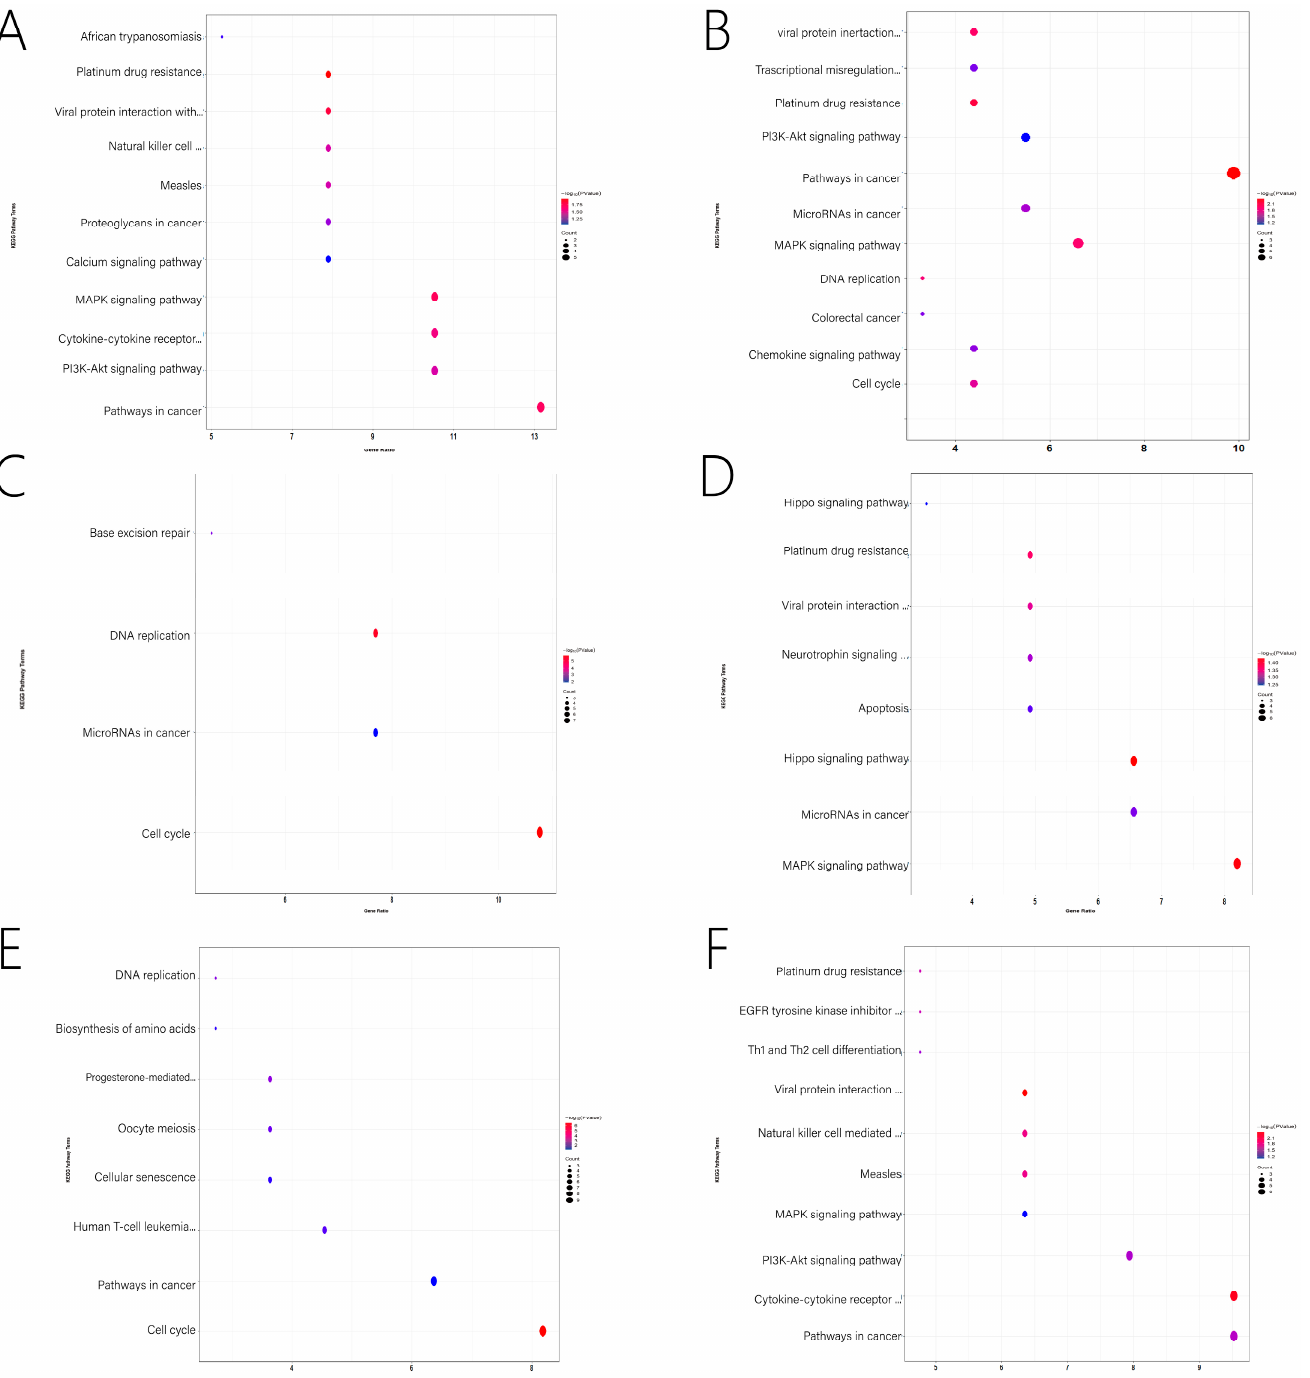
Figure 7. KEGG pathway analysis of related Specific module genes. ( A ) The pathway enrichment for the N-light cyan module. ( B ) The pathway enrichment for N-midnight blue module. ( C ) The pathway enrichment for N-light green module. ( D ) The pathway enrichment for the N-grey module. ( E ) The pathway enrichment for M-light green module. ( F ) The pathway enrichment for the M-light cyan module.